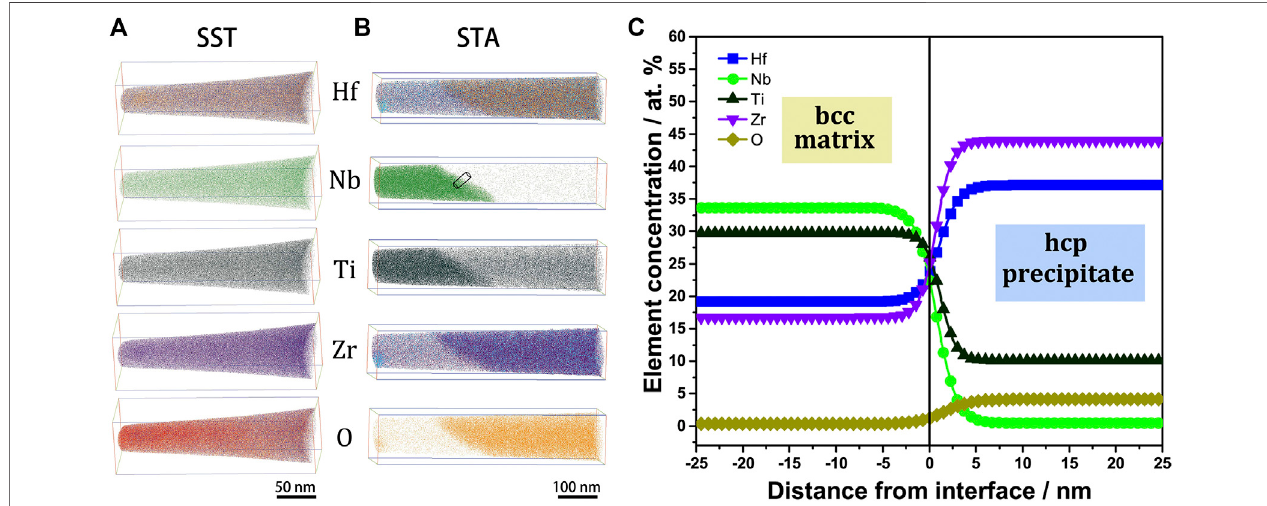
FIGURE 3 | 3D-reconstruction images for (A) O-2.0-SST and (B) O-2.0-STA, (C) Chemical composition along the long axis of the cylinder area marked in (B) .